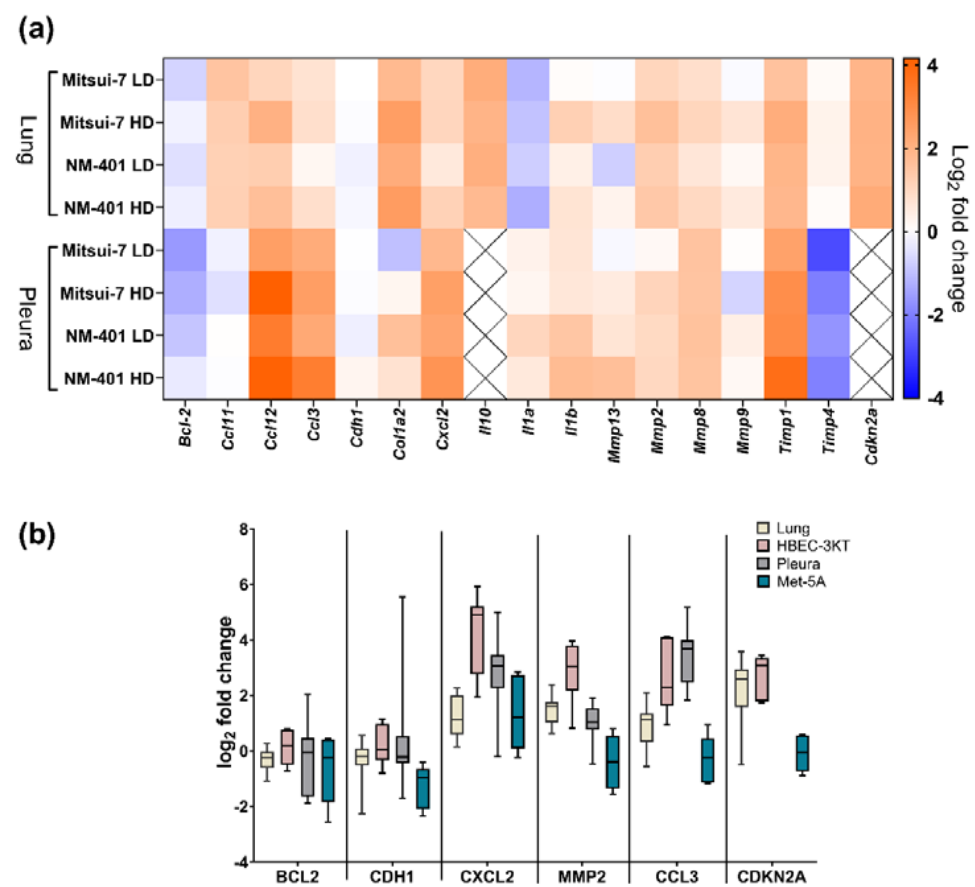
Figure 2. Effects of multiwalled carbon nanotubes (MWCNT)-exposure on genes involved in fibrosis and inflammation in vitro and in vivo. ( a ) Heatmap illustrating median fold changes in gene expres- sion in pleura and lung following intrapleural injection of MWCNT Mitsui-7 and NM-401. Low dose (LD), high dose (HD); n = 12–18. ( b ) Selected genes following exposure to NM-401 high dose. Cellular data are merged data from all time points ( n = 6). Data indicate mean ± 5